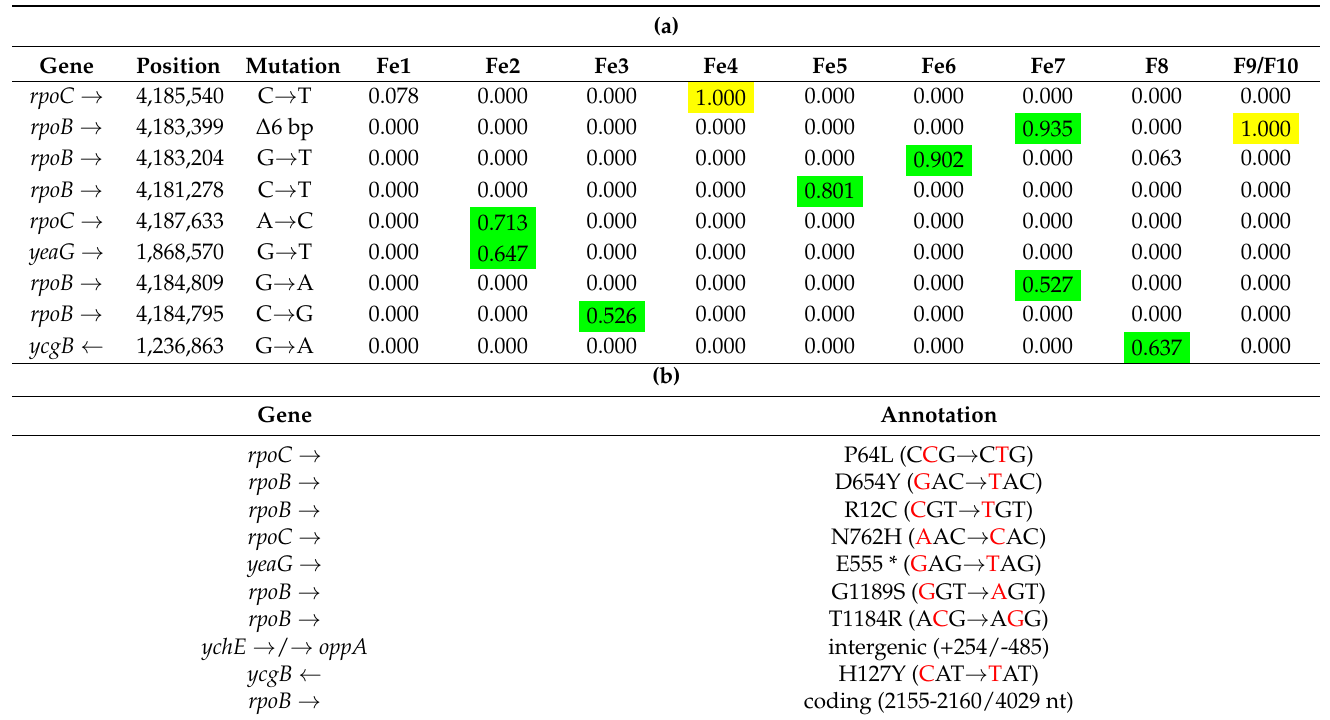
(Fe4) and two iron (III) replicates (Fe 9, Fe10) displayed a selective sweep (yellow) for rpoC (yellow), and two out of four (Ph2, Ph3) displayed significant polymorphism (green) at tive sweeps (yellow) and significant (green) polymorphisms detected in five replicates of iron (III)/phage-resistant populations. Two of the four selective sweeps, in genes waaC, and rpoB, were also detected in the phage-resistant and iron (III)-resistant populations, respectively. While two selective sweeps, in genes rcsA and hldE, were unique to the iron (III)/phage-resistant populations (Table 5) at day 35. Supplementary Tables S3—S5 list the minor polymorphisms detected in iron (III)/phage-, iron (III)-, and phage-resistant populations at day 35, respectively. Table 3. ( a ) Position of selective sweeps (yellow) and significant polymorphisms (green) in iron (III)-resistant populations at day 35. ( b ) Annotation of genes mutated (red-nucleotides changed) in iron (III)-resistant populations at day 35. Selective sweep is determined by an increase in frequency of a de-novo mutation to 1.000. A significant polymorphism is determined by an increase in frequency of a de-novo mutation to between 0.500 to 0.999. Stop codons are symbolized as *. (a)